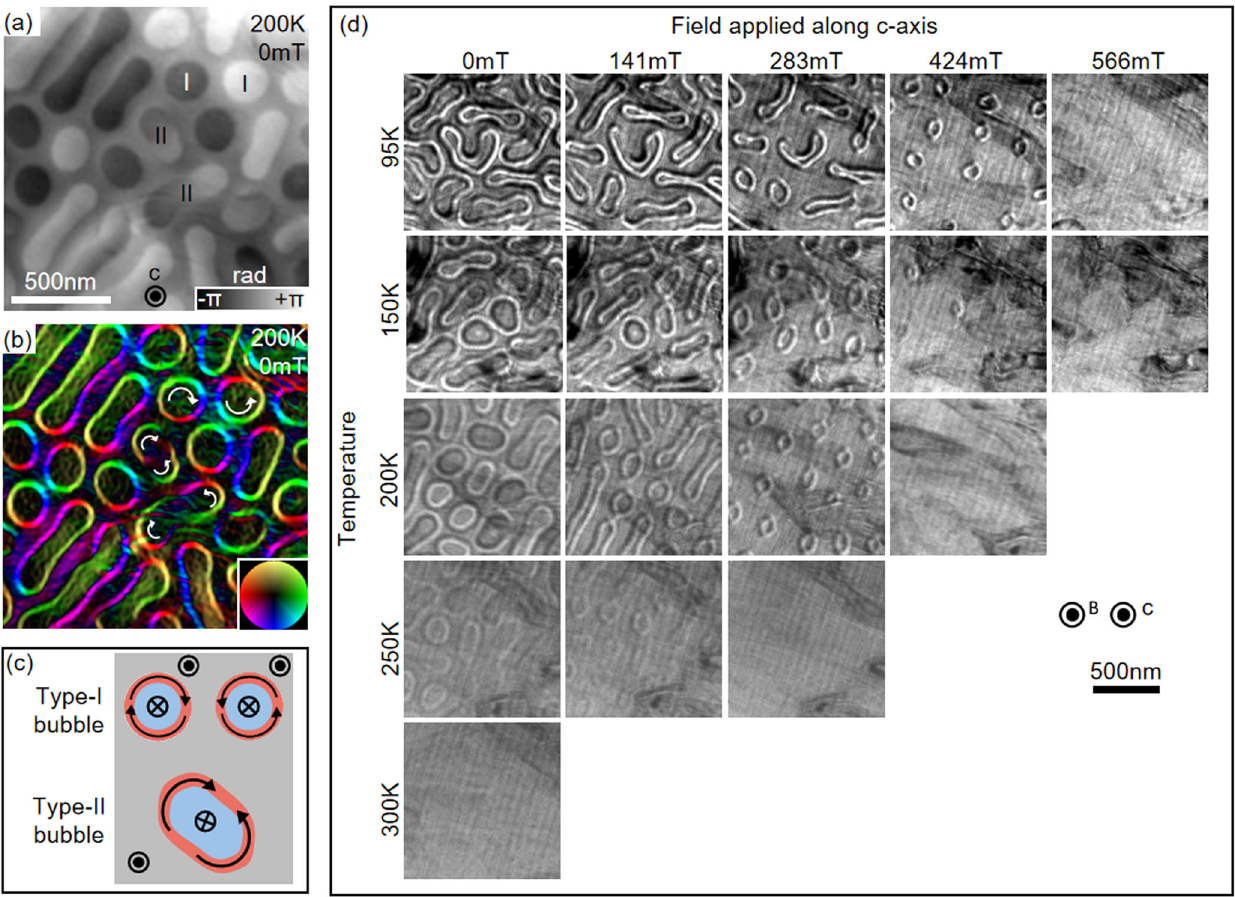
Fig. 2 Magnetic imaging of Fe 5 GeTe 2 in the pre-cooling phase, revealing skyrmionic spin structures. a Phase shift image obtained using off-axis electron holography at T = 200 K and B = 0 mT in Fe 5 GeTe 2 with the c-axis perpendicular to the image plane after previously applying out-of-plane fi elds up to B = 566 mT. b Corresponding color-coded magnetic induction map where the direction of the magnetic fi eld is given by the color wheel. Type-II as well as type-I bubbles with opposite winding numbers are present. c Schematic illustration of type-I and type-II bubbles. d Series of Fresnel images taken at various temperatures and external out-of-plane fi elds (parallel to the c-axis) with a defocus of − 1 mm, in a ≈ 100 nm thick plan-view lamella (c-axis is perpendicular to the image plane). The magnetization within the magnetic bubbles opposes the external fi eld, whereas the areas the magnetization between the bubbles are parallel to the fi eld. Bubbles begin to form at higher external fi elds for lower